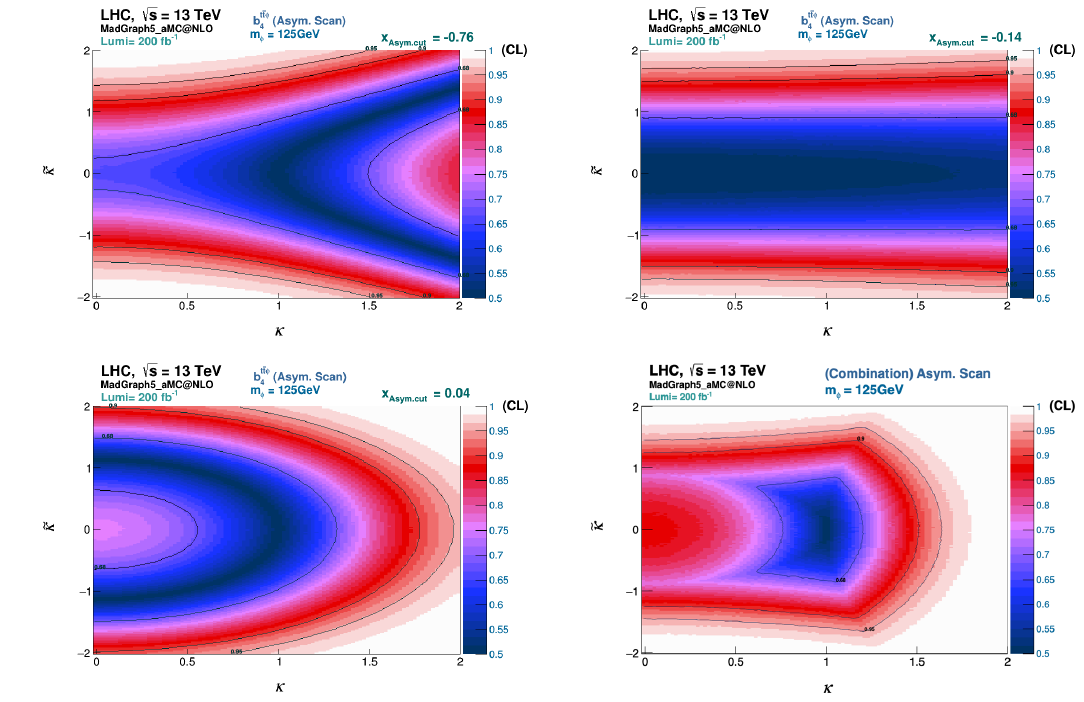
Figure 8 . CLs for the exclusion of the SM with a 125 GeV Higgs boson φ with mixed scalar and pseudo-scalar couplings (CP-mixed case), against the SM as null hypothesis, for the b t ¯ tφ (top- and bottom-left and top-right) and best exclusion limits from all observables (bottom-right). Limits are shown for a luminosity corresponding to the full RUN 2 data and first year of RUN 3 i.e., L =200 fb − 1 and as a function of different cut-off values applied to b t ¯ tφ x c =-0.14 (top-right) and x c =+0.04